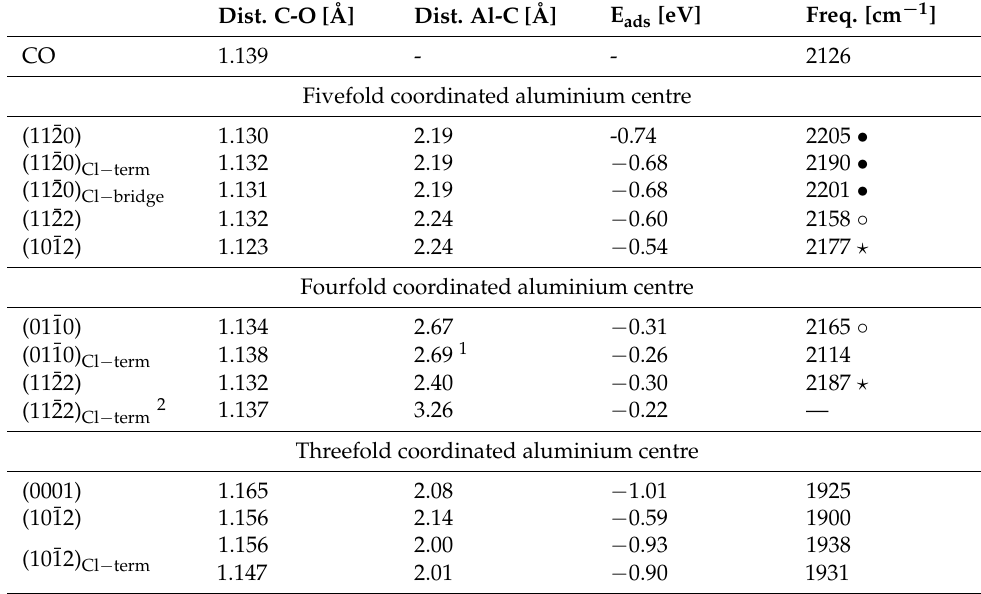
Table 2. PBE-D3(BJ) results of the adsorption properties of CO on different α -AlF 3 -surfaces and